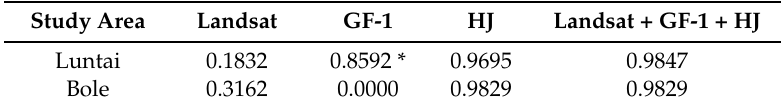
Table 6. Proportion of good observations (PGQ) of each satellite.